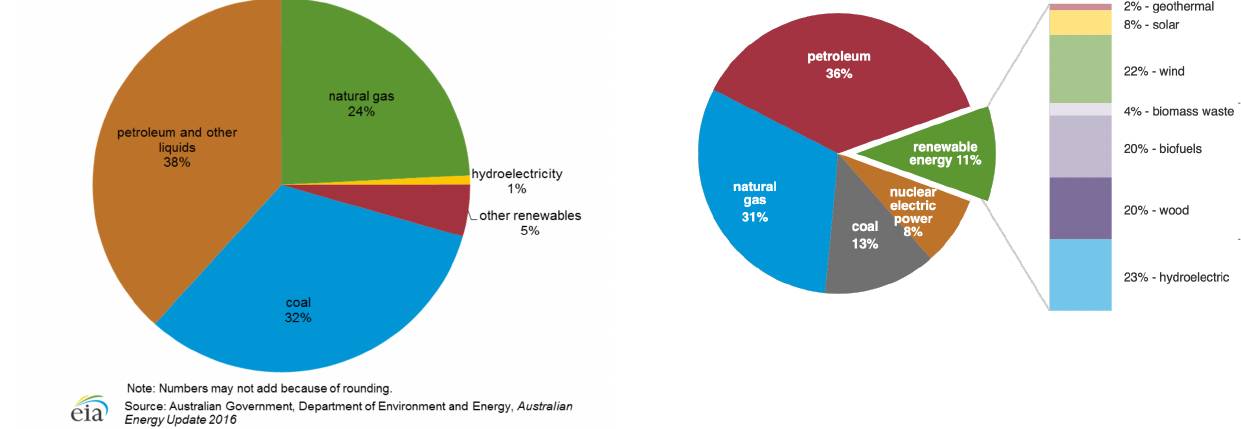
Figure 2. Energy consumption in United States in 2017